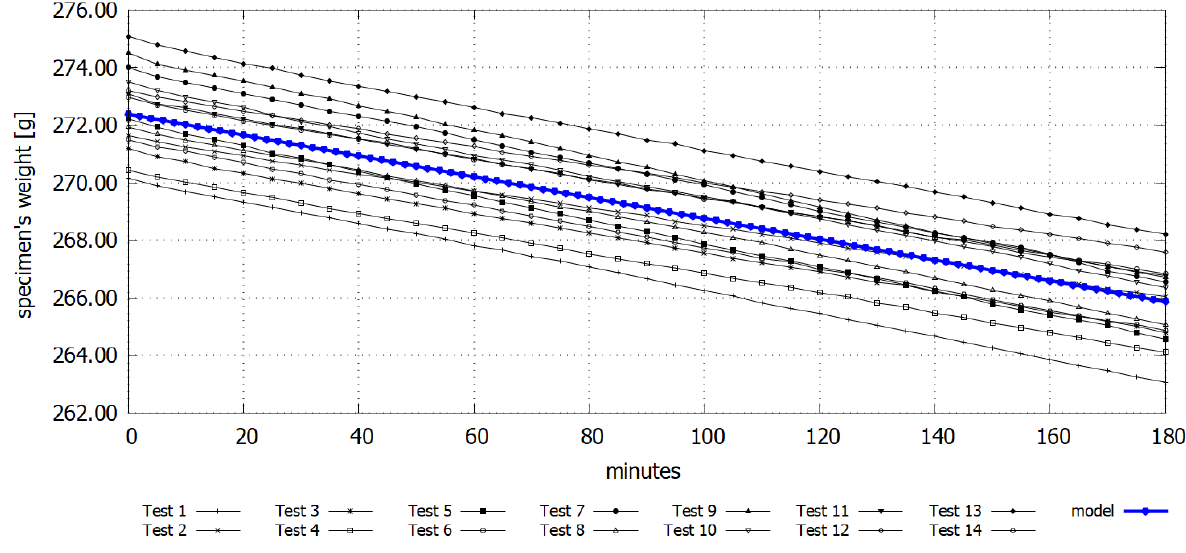
Figure 7. Time course of the weight loss due to evaporation of 14 concrete specimens during 180 minutes. The weight loss has been used as reference for the concrete surface